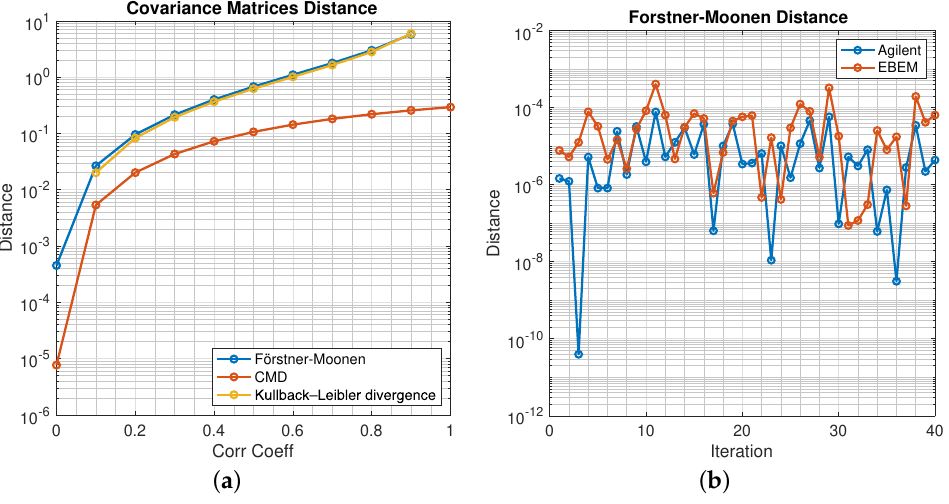
Figure 3. Two illustrations of the effectiveness of the Förstner-Moonen distance. All three similarity measures behave monotonically with correlation with the Kullback-Leibler measure virtually co- incident with Förstner-Moonen. ( a ) Comparison of Förstner-Moonen, CMD and Kullback-Leibler distance metrics, ( b ) The Förstner-Moonen distance is lower when data are transformed by matched whitening